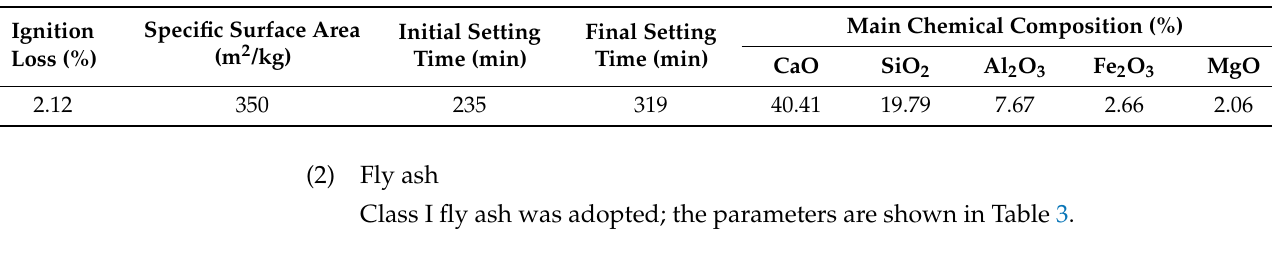
Table 3. Physical properties and main chemical composition of fly ash.